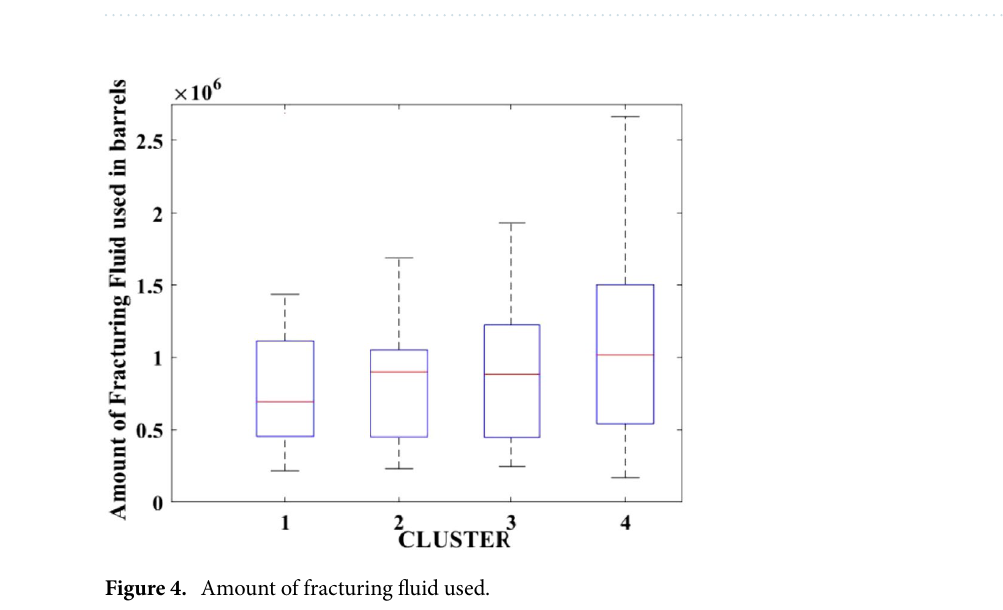
Figure 3. Amount of proppant used.